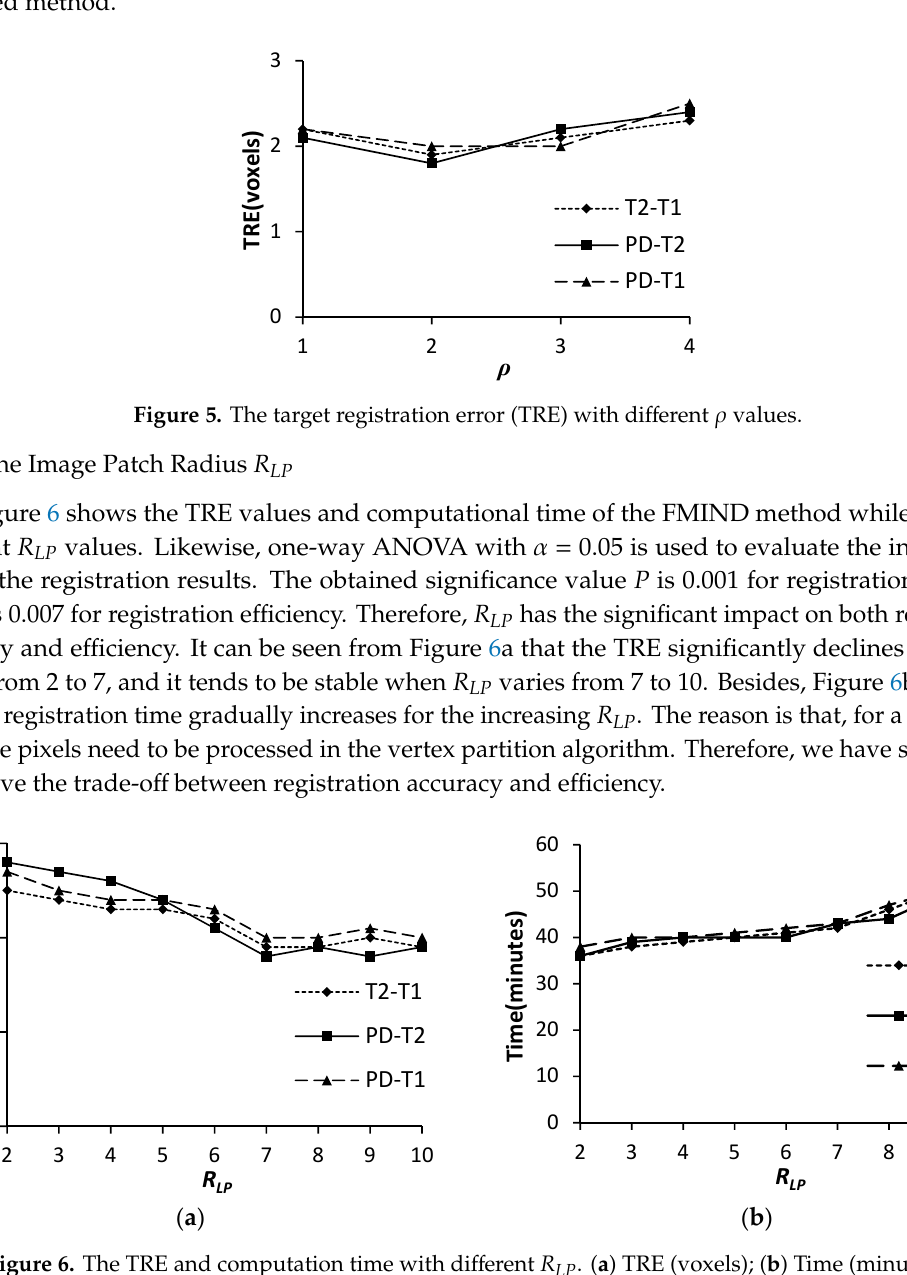
Figure 6. The TRE and computation time with di ff erent R LP . ( a ) TRE (voxels); ( b ) Time (minutes).